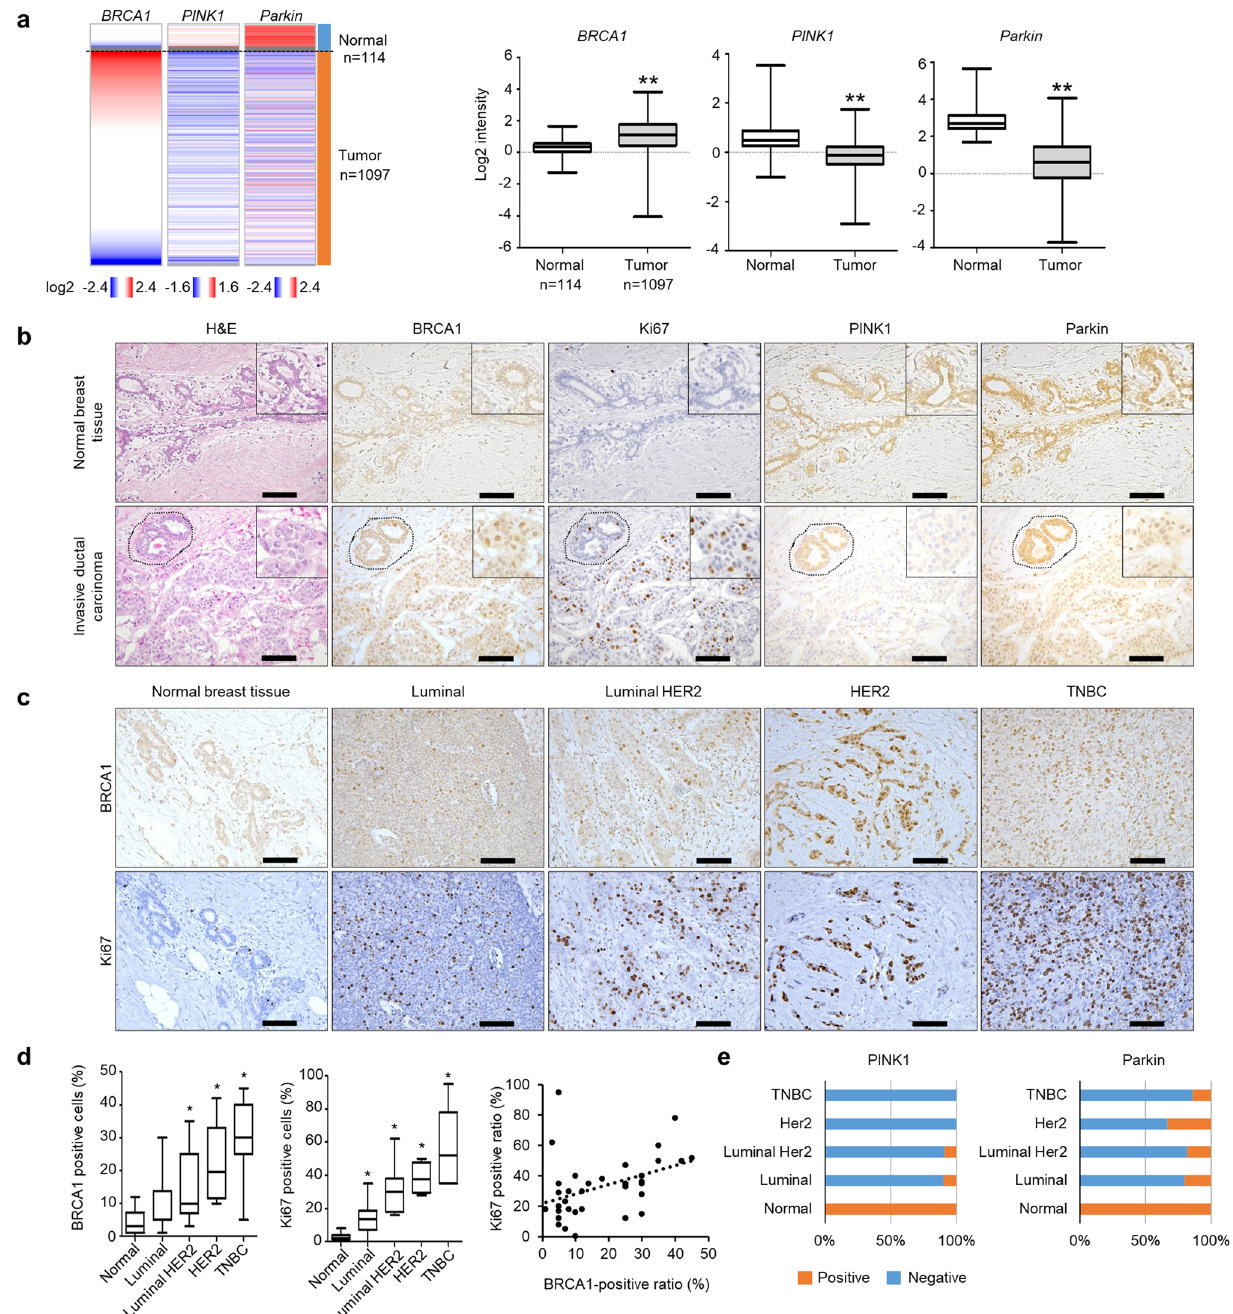
Figure 4. BRCA1 expression is inversely correlated with PINK1/Parkin expression in breast cancer tissues. ( a ) BRCA1, PINK1, and Parkin mRNA expression levels in human breast cancer patients were obtained from the TCGA database and summarized as a heat map (left) or box plot (right). ** p < 0.01 versus normal tissues. ( b ) BRCA1, Ki67, Parkin, and PINK1 expressions in normal breast tissues and breast cancer tissues from patients were assessed by immunohistochemistry. The figures shown are representative images. On the images of invasive ductal carcinoma, circles with dashed lines indicate noncancerous breast epithelial tissues in the same images. Scale bar = 100 μm. ( c ) Immunohistochemical staining of BRCA1 and Ki67 in normal breast tissue and each subtype of breast cancer tissue. TNBC: triple negative breast cancer showing no ER, PgR, and HER2. ( d ) The left and middle graphs indicate the number of cells positive for BRCA1 or Ki67 [analyzed by IHC and shown in (C)] as a box plot. * p < 0.05 versus normal tissue. The right graph shows the correlation between the BRCA1-positive ratio and the Ki67-positive ratio in breast tumor tissue. Spearman’s correlation coefficient was analyzed ( n = 34, r = 0.4245, p = 0.0123). ( e ) Summary of the Parkin- and PINK1-positive or -negative sample ratio in normal breast tissue and each subtype of breast cancer. Slides with Parkin- and PINK1-positive tissues were counted in each subtype, and the difference in the number of positive and negative slides between normal and tumor tissues was analyzed using the Chi-square test. The analysis revealed a significant difference in the PINK1 and Parkin expressions among the subtypes. p < 0.01 for Parkin and PINK1. In ( d , e ), the n for normal is 12, the n for luminal is 10, the n for luminal HER2 is 11, the n for HER2 is 6, and the n for TNBC is